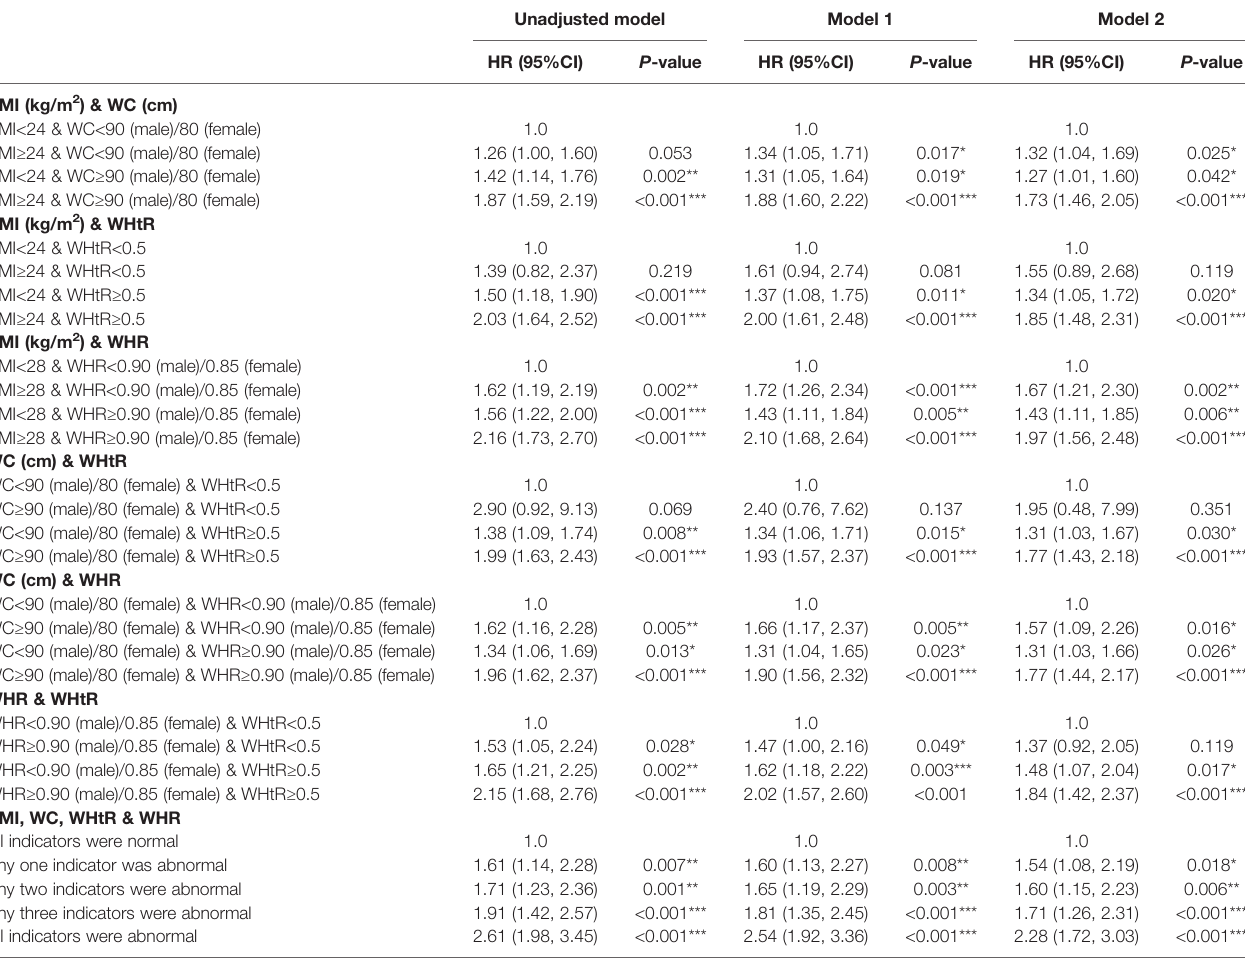
TABLE 3 | Multivariate cox regression models evaluating the associations of different combinations of BMI and established anthropometric indices of central obesity (WC, WHR and WHtR) with the development of diabetes. Unadjusted